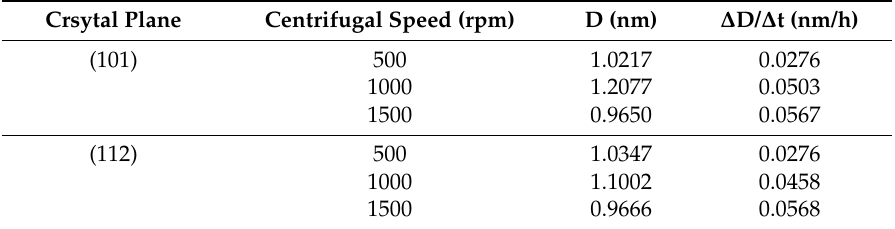
Table 5. Selectivity of crystal growth direction for NH 4 ReO 4 crystals at different centrifugal